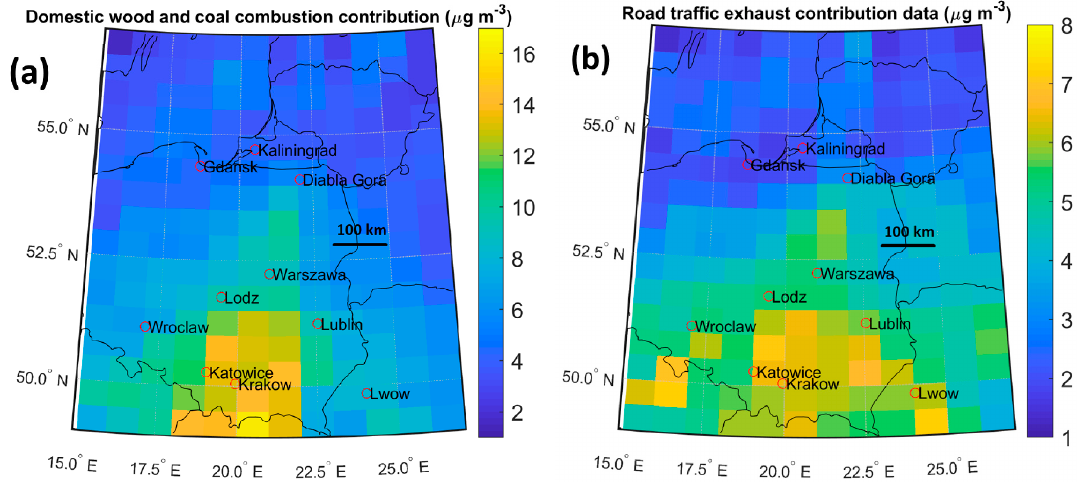
Figure 4. Diabła Góra CM source contributions from ( a ) domestic wood and coal combustion, and from ( b ) road traffic exhaust as function of grid cell origin for grid cells with 0.5 and 1 degree resolution in the latitudinal and longitudinal direction. Data taken from aethalometer model with 1-h resolved aethalometer and trajectory data.